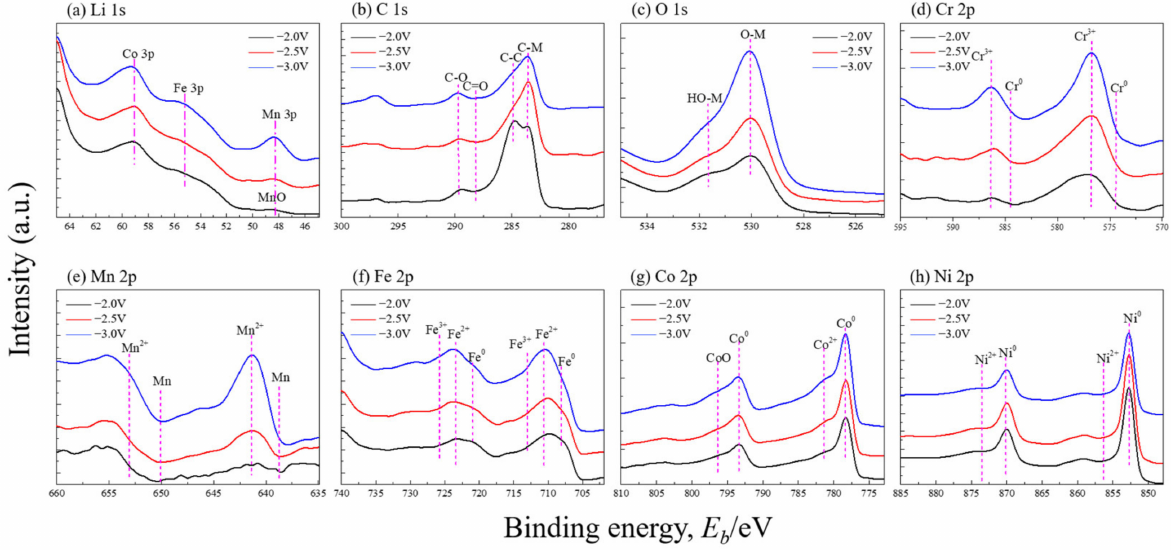
Figure 9. XPS spectra of Li 1s ( a ), C 1s ( b ), O 1s ( c ), Cr 2p ( d ), Mn 2p ( e ), Fe 2p ( f ), Co 2p ( g ), and Ni 2p ( h ) from coating B obtained at − 2.0 V, − 2.5 V, and − 3.0 V (vs. SSE) for 0.6